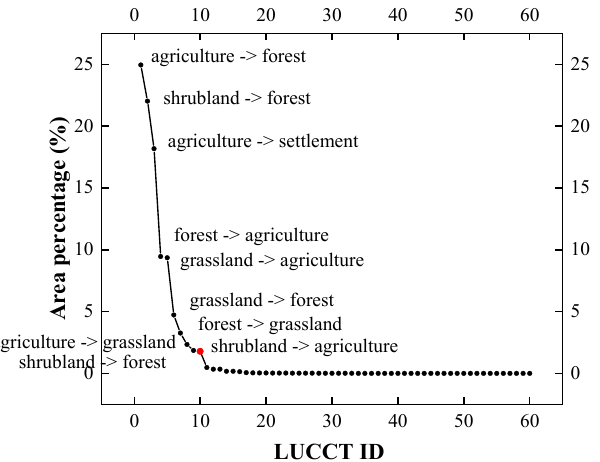
Figure 4. Area percentage of each LUCCT amongst all LUCCTs in descending order in 2001–2015. The red point represents the boundary of major and minor LUCCTs, and the LUCCT ID is defined by the percentage of area in descending order.